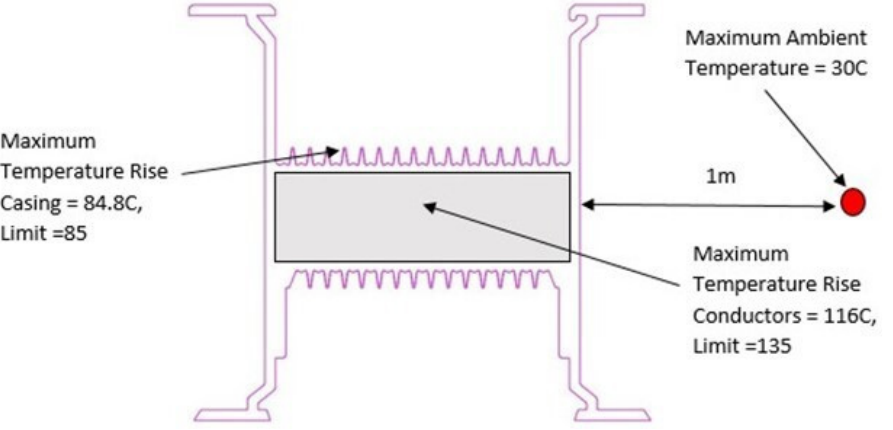
Figure 6. The temperature rise at bus duct conductor parts.